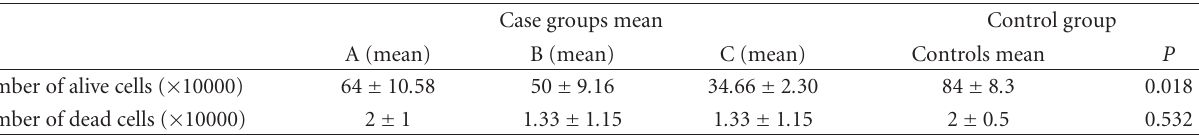
Table 2: The number of dead or alive cells in flasks with BHK cells following 48 hours of treatment with 10 (A), 50 (B), or 100 (C) hydatid cyst protoscolices (case groups) or left intact (control group) (mean triplicate performance).